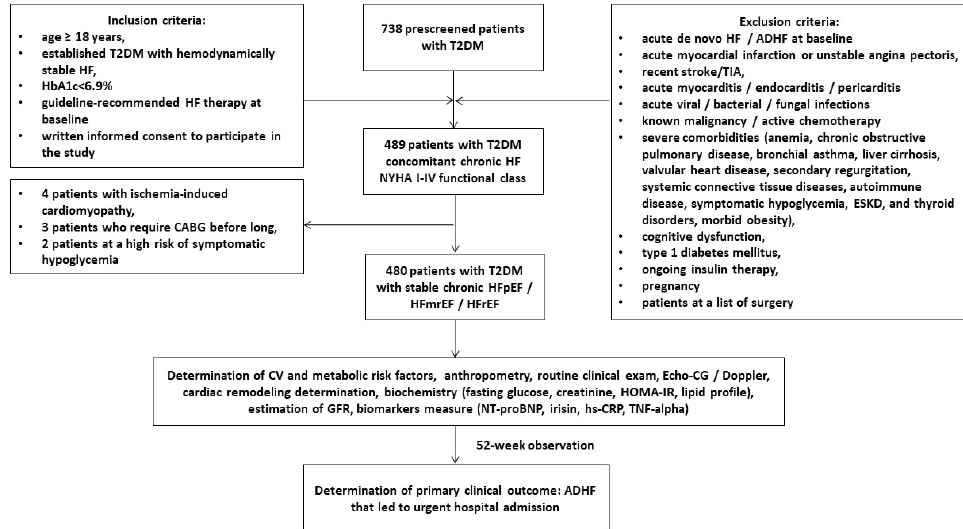
Figure 1. Flow chart of the study design. Abbreviations: ADHF, acutely decompensated heart failure; CV, cardiovascular; Echo-CG, echocardiography; GFR, glomerular filtration rate; HF, heart failure; HFpEF, heart failure with preserved ejection fraction; HFmrEF, heart failure with mildly reduced ejection fraction; HFrEF, heart failure with reduced ejection fraction; hs-CRP, high sensitivity C-reactive protein; HOMA-IR, Homeostatic Assessment Model of Insulin Resistance; HbA1c, glycosylated hemoglobin; NT-proBNP, N-terminal brain natriuretic pro-peptide; T2DM, type 2 diabetes mellitus; TIA, transient ischemic attack; and TNF-alpha, tumor necrosis factor-alpha.